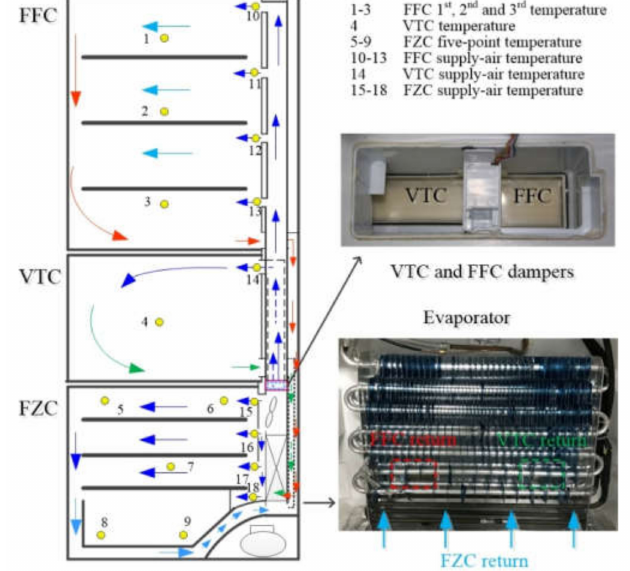
Figure 1. Schematic structure of the refrigerator with